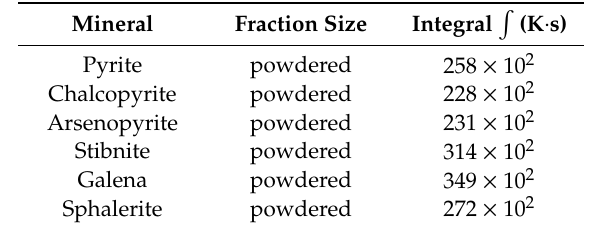
Table 5. Integrals beneath temperature–time progression curves for the various powdered sulphide minerals. Integrals were only calculated for closed temperature–time progression curves. For the integral calculation the temperatures were converted from ◦ C to K and the time was converted from minutes [min] to seconds [s].